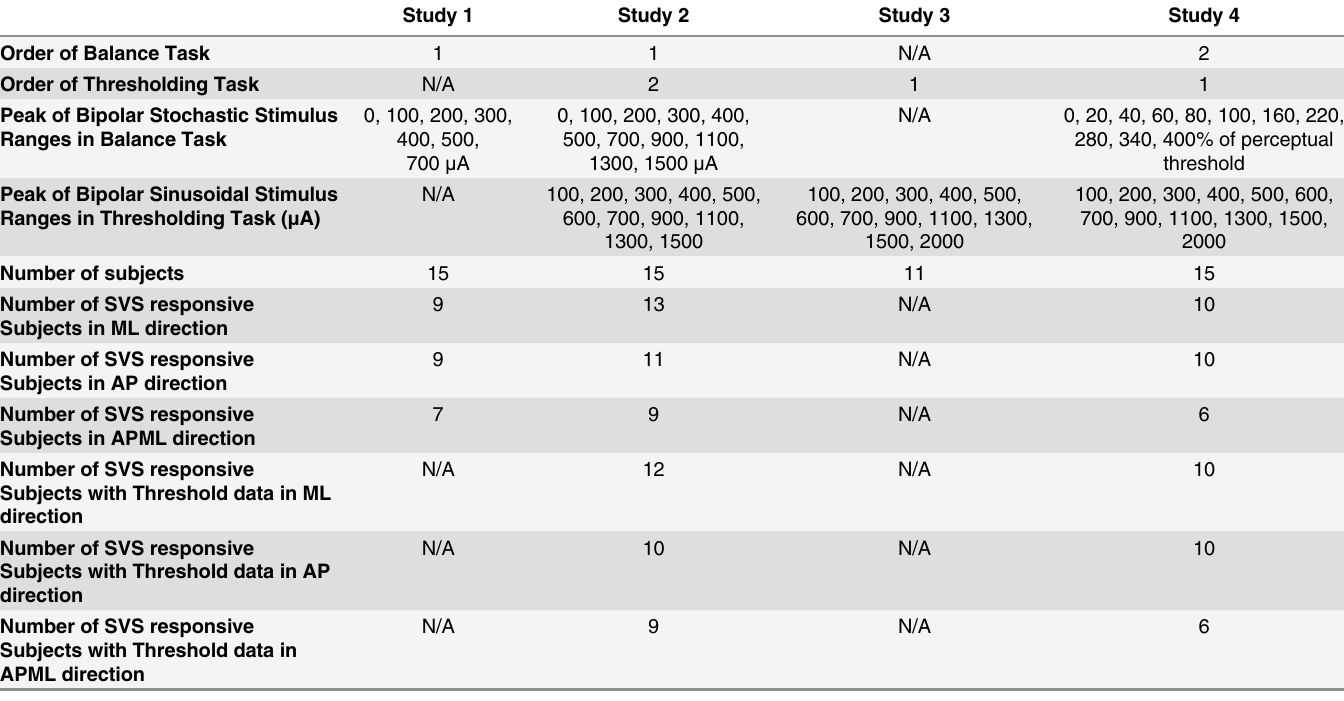
Study 1 Study 2 Study 3 Study 4 Order of Balance